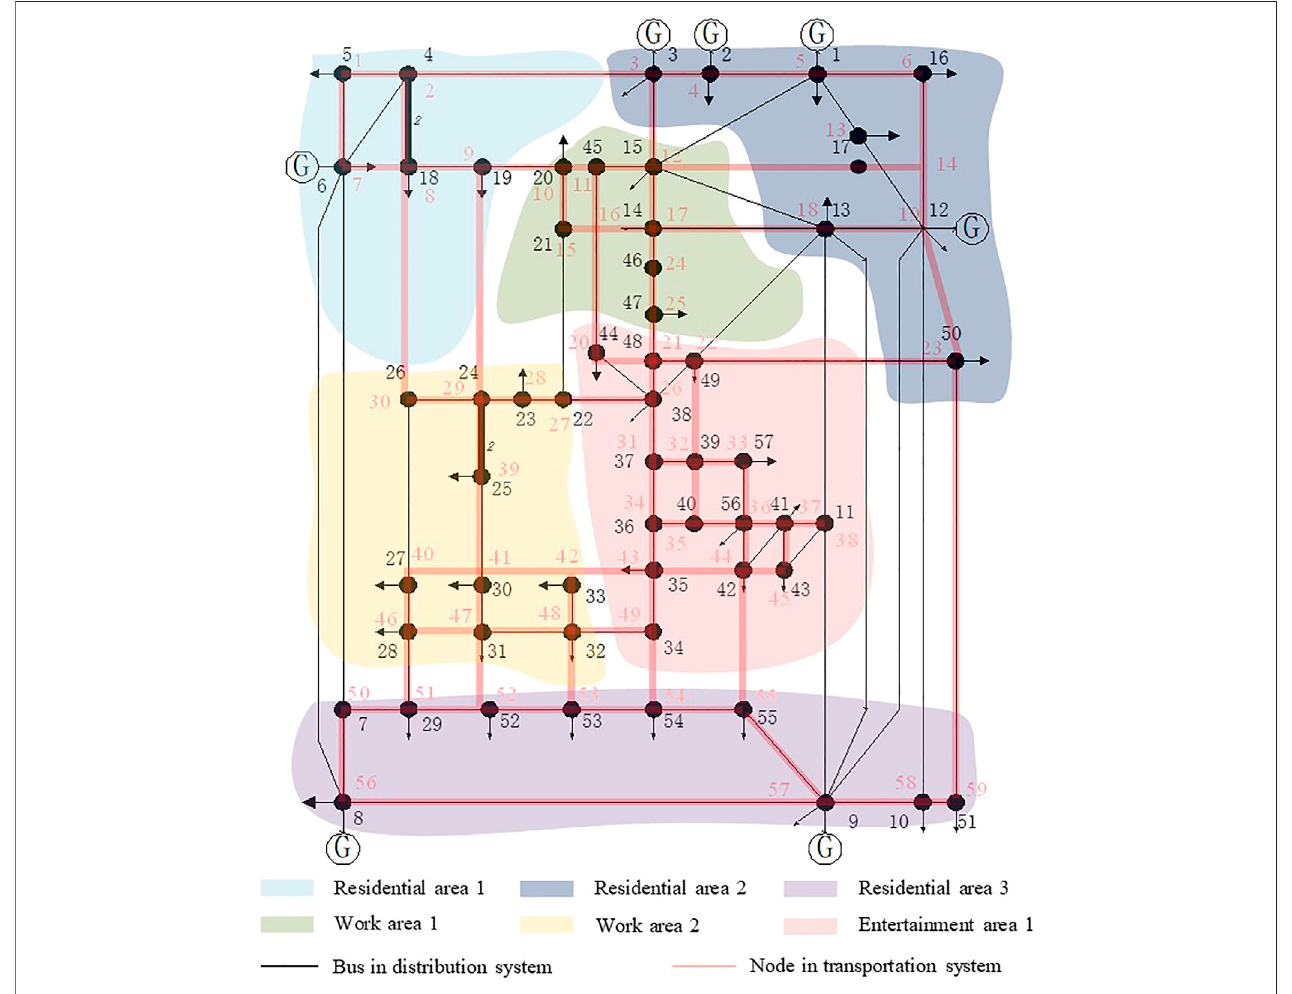
FIGURE 4 | Coupled system of distribution and transportation